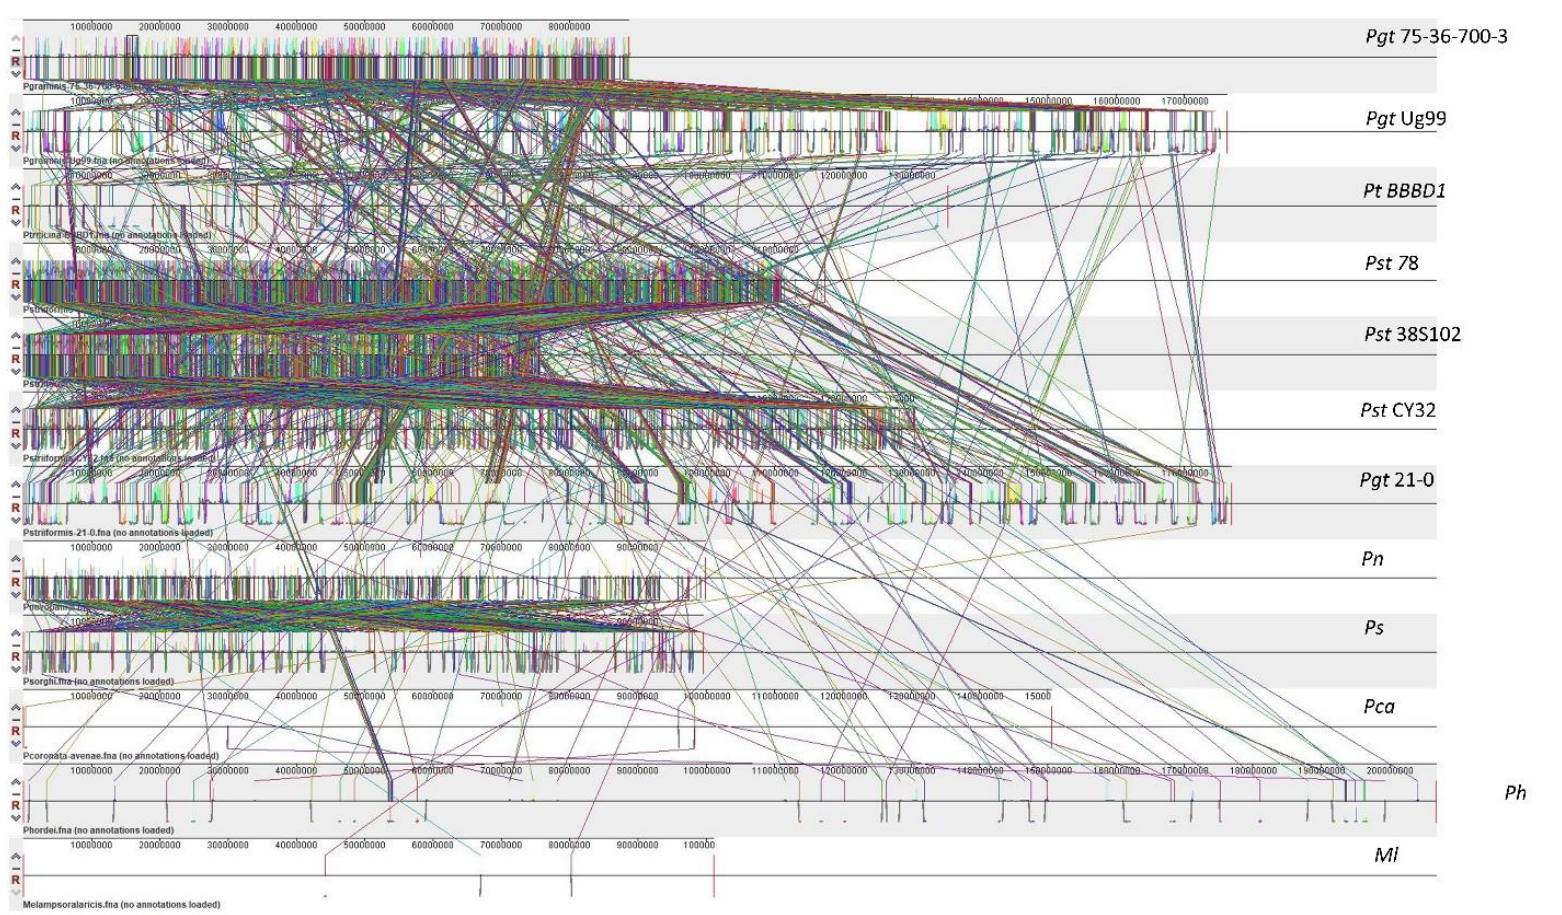
Figure 1. Synteny and collinearity of Puccinia genomes. This figure represents a synteny plot generated by Progressive Mauve between Pgt 21–0, Pgt Ug99, Pgt 75-36-700-3, Pt BBBD1, P. novopanici, Pst CY32, Pst 78, Pst 38S102, P. coronata, P. hordei, P. sorghi and an outlier Melampsora laricis . Colored blocks represent locally collinear blocks (LCBs) between different Puccinia genomes. The crisscross lines between any two genomes are the LCB strikethrough lines. There are 3485 LCBs in all Puccinia spp. with a seed weight of 39 for anchored positions. Abbr: Puccinia graminis tritici ( Pgt ); Puccinia striiformis tritici ( Pst ); Puccinia triticina ( Pt ); Puccinia coronata avenae ( Pca ); Puccinia novopanici ( Pn ); Puccinia sorghi ( Ps ); Puccinia hordei ( Ph ); Melampsora laricis (Ml).